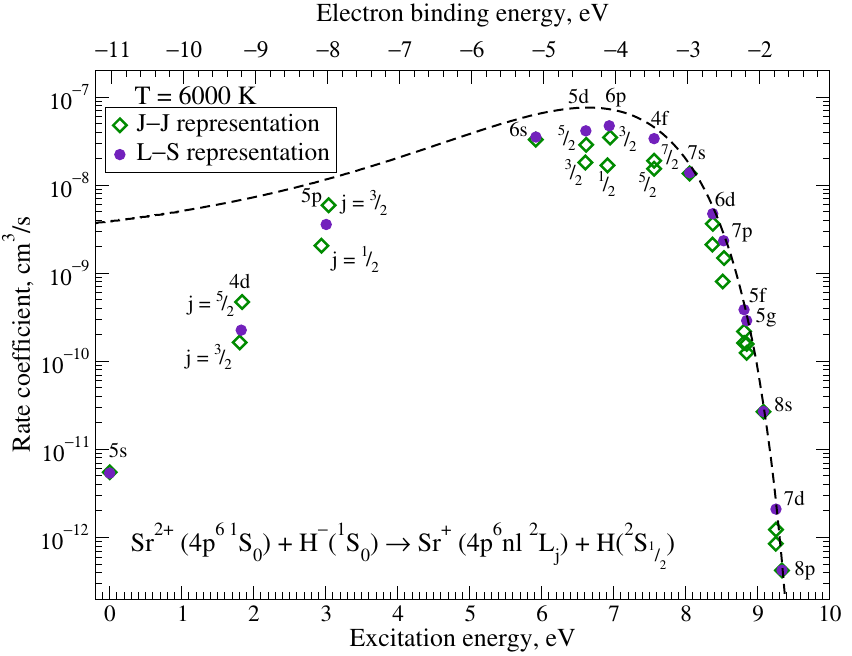
Figure 2. The rate coefficients (in cm 3 /s) at T = 6000 K for the neutralization processes in (cid:0) (cid:1) + Sr 2 + 4 p 6 1 S 0 H − ( 1 s 2 1 S 0 ) collisions. Empty diamonds correspond to the calculations with the account for the fine structure; filled circles, to the calculations without fine structure; and dashed line shows the general dependence of the rate coefficient according to the simplified quantum model